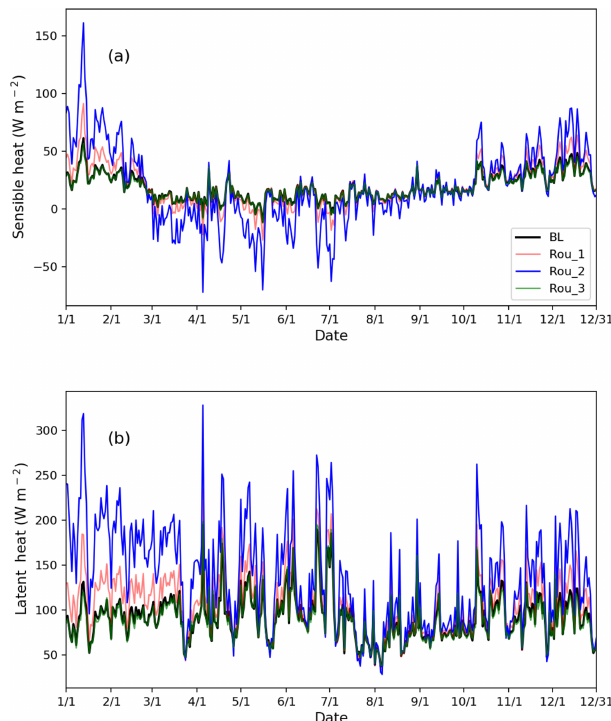
Figure 11. Time series of (a) upward sensible heat flux, (b) upward latent heat flux by BL (black line), Rou_1 (red line), Rou_2 (blue line), and Rou_3 (green line) of Nuozhadu Reservoir in